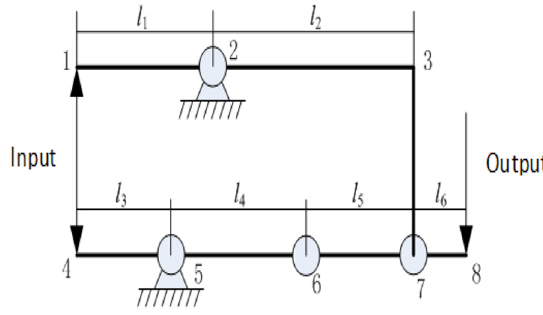
Fig. 1. Reverse drive principle.